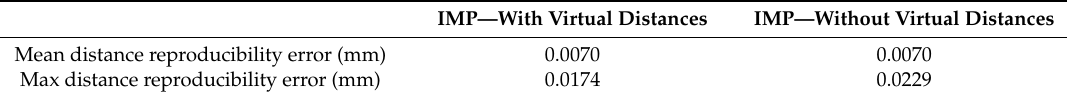
Table 9. Distance reproducibility errors in AACMM verification procedure with IMP (with and without virtual